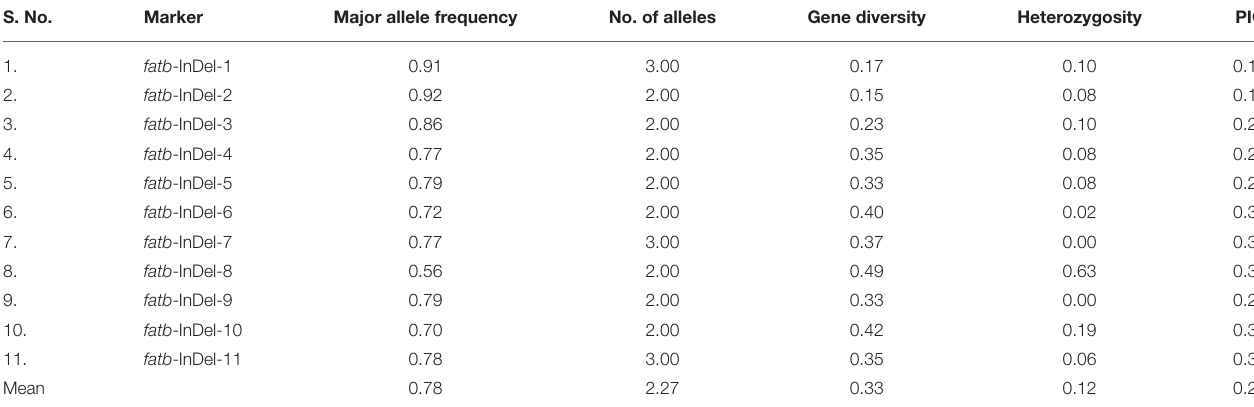
TABLE 3 | Molecular diversity parameters among the 48 diverse genotypes using gene-based InDel markers. S. No. Marker